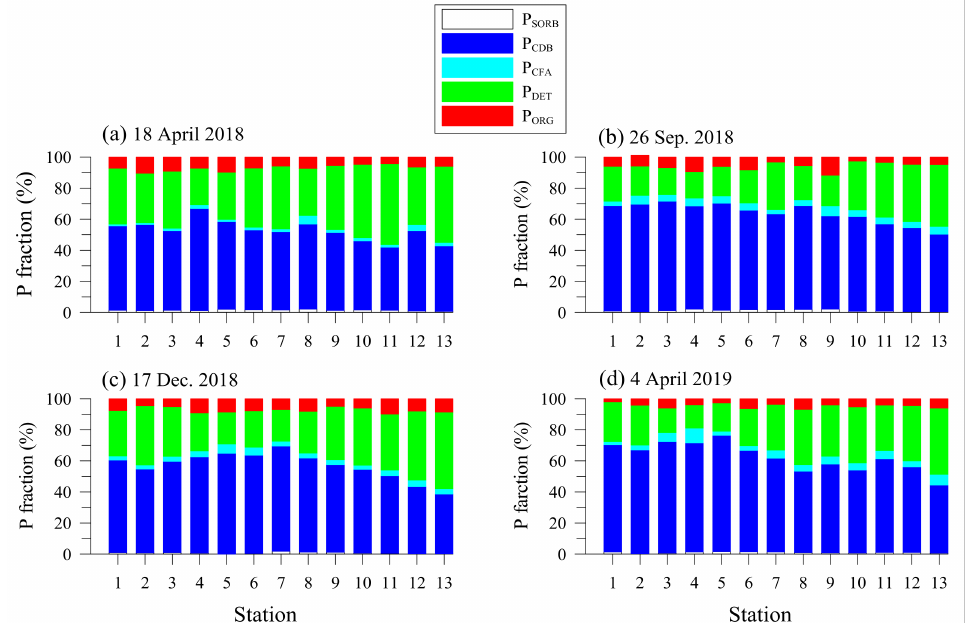
Figure 7. Percentage of each P concentration fraction to the total P concentrations in the DRE surface sediments during the different surveys ( a ) 18 April 2018, ( b ) 26 September 2018, ( c ) 17 December 2018, and ( d ) 4 April